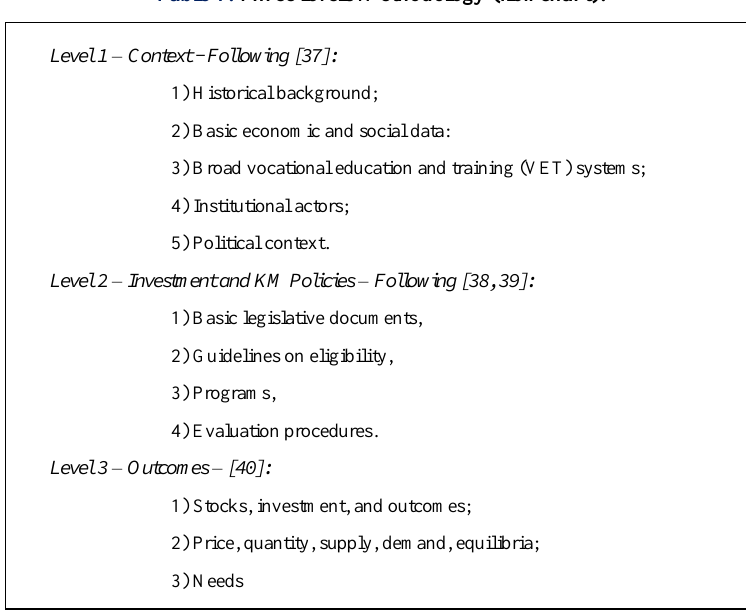
Table 1. Three levels Methodology